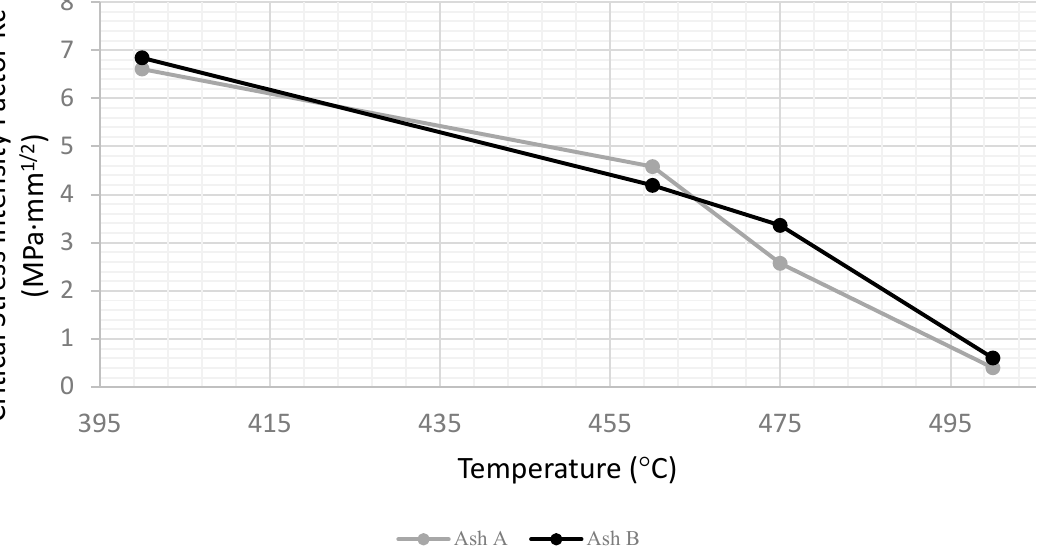
Figure 13. Critical stress intensity factor versus temperature of Ash A and Ash B.